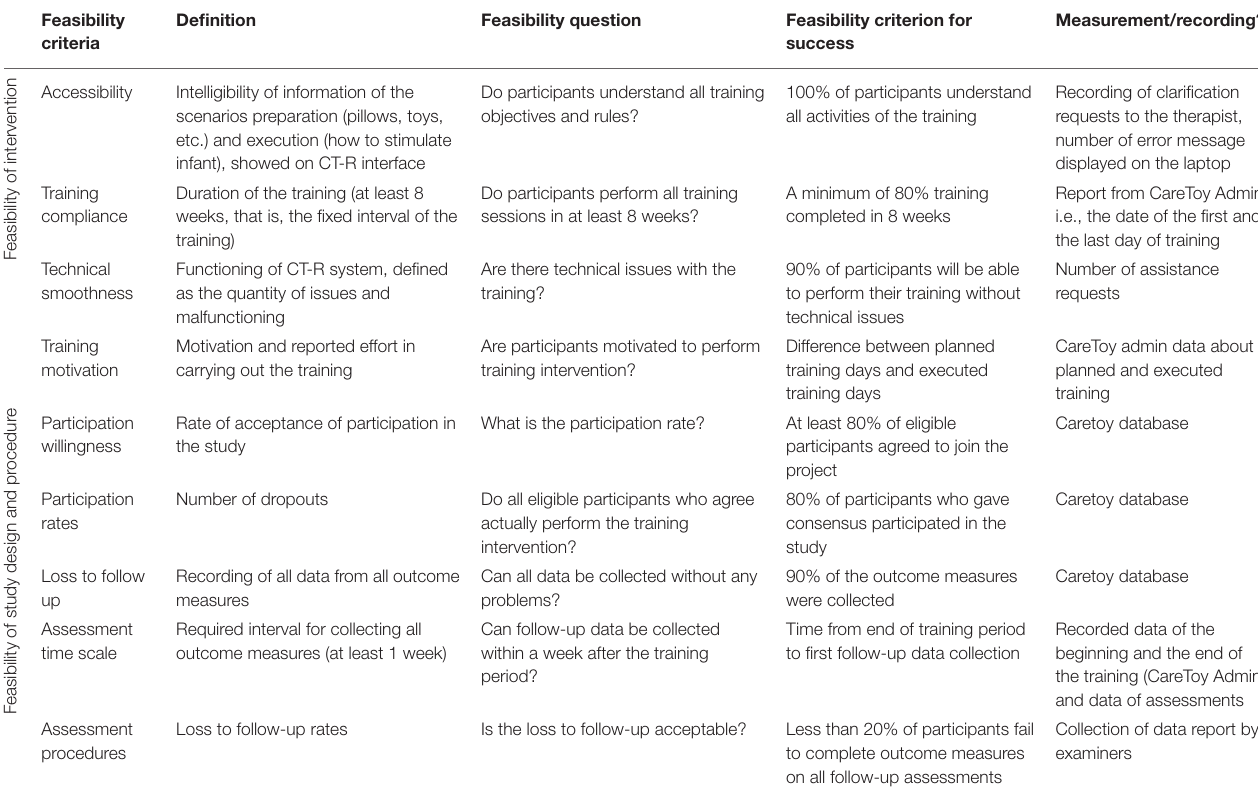
TABLE 1 | Feasibility criteria.